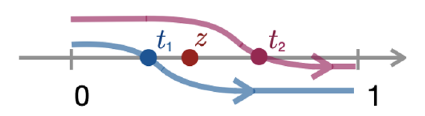
Figure 5 . The integration contours associated with the left and right actions of